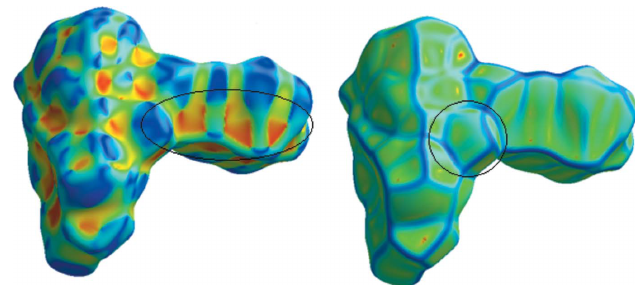
Figure 3 Hirshfeld surface over d norm generated for the title compound and neighbouring molecules linked via O—H (cid:2)(cid:2)(cid:2) O hydrogen bonds (dashed lines). [Symmetry codes: (i) x , y + 1, z ; (iii) x , y (cid:4) 1, z .]